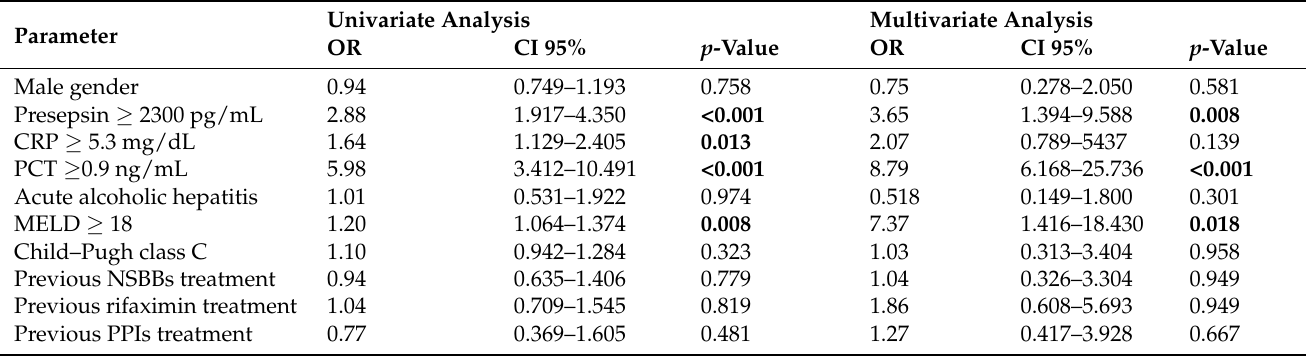
Table 2. Univariate and multivariate logistic regression analyses of factors associated with infections in patients with